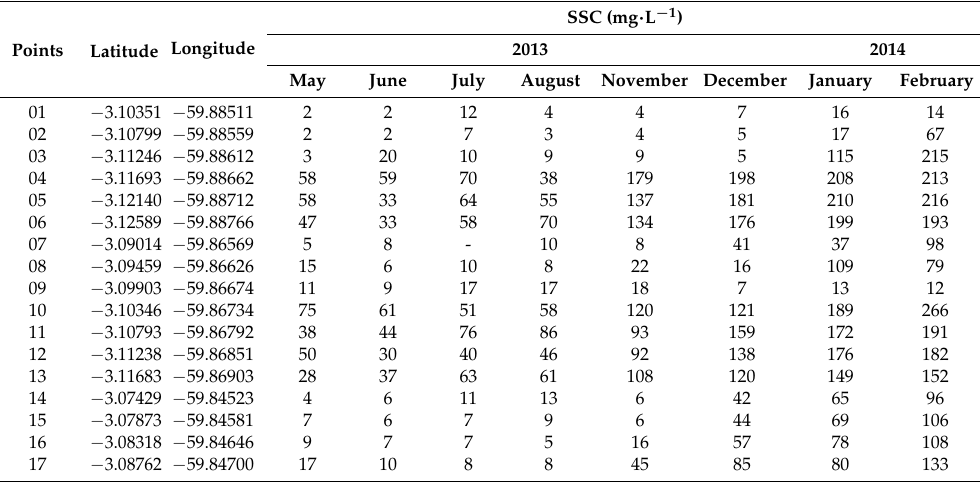
Table 1. Values of Suspended Sediment Concentrations (SSC) obtained in the field every month during the 2013–2014 period. Geographic coordinates and data are in WGS